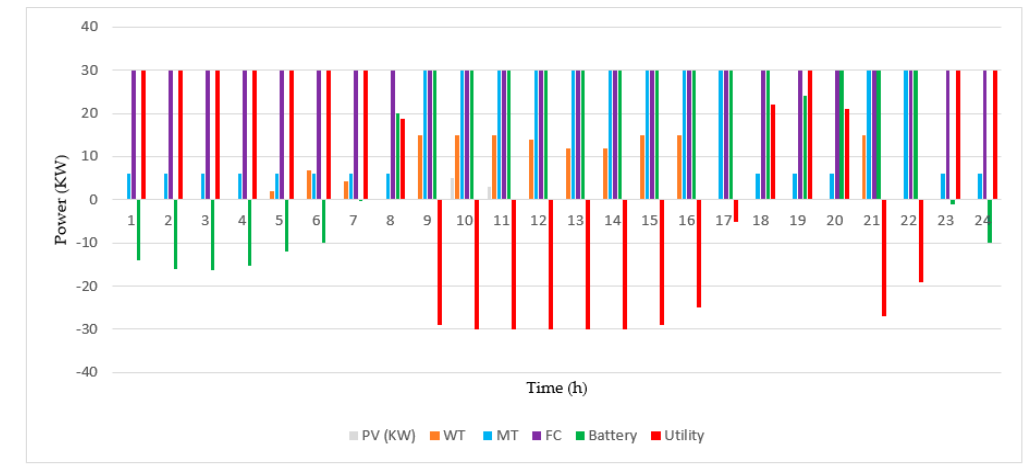
Figure 14. The optimal output power from the installed DG units for the second scenario.